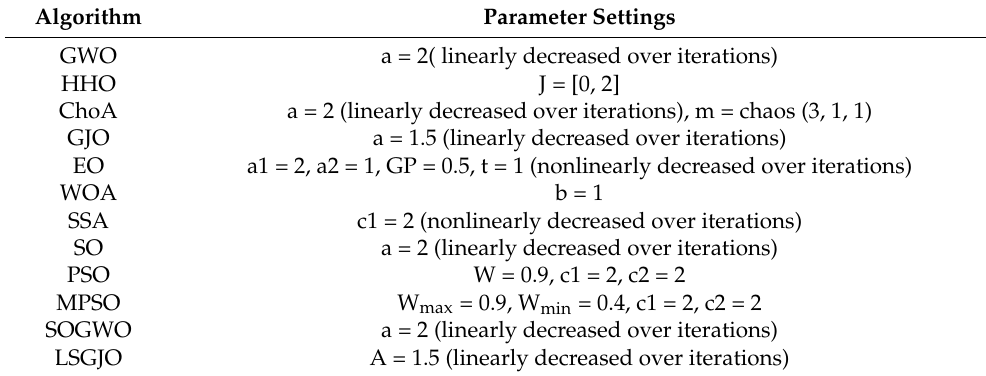
Table 2. Parameter settings of various algorithms.